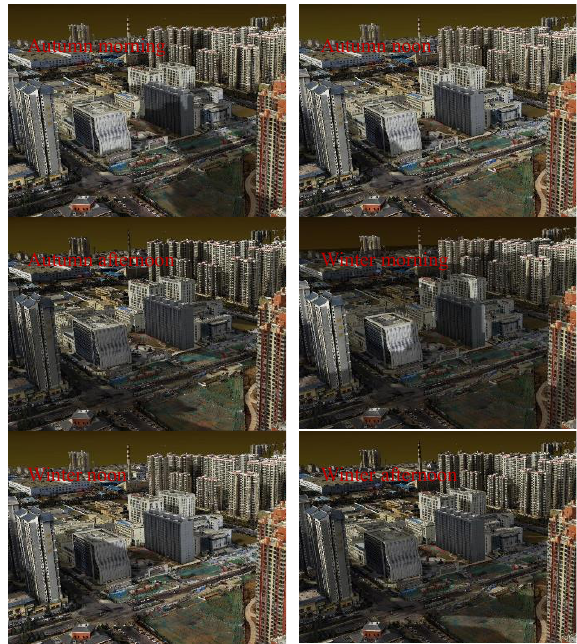
Figure 6.Analysis of sunshine in different seasons